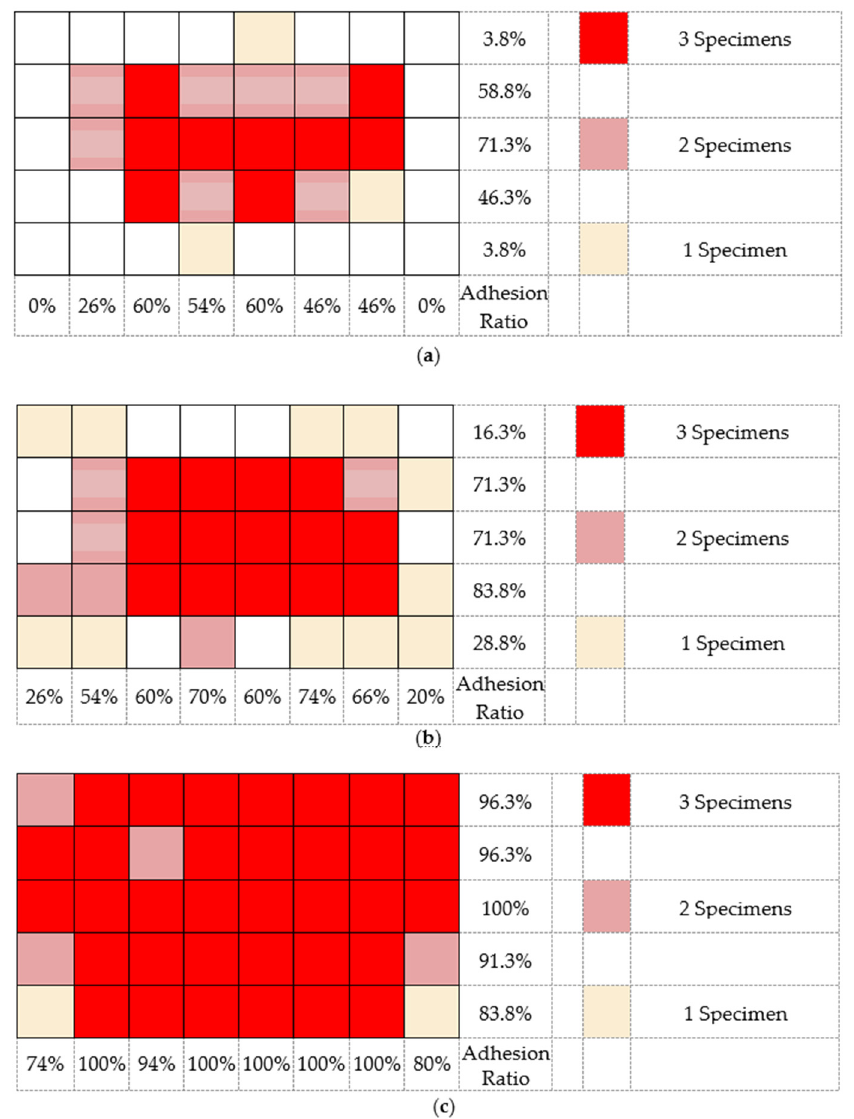
Figure 13. Adhesion ratio distribution map of specimens based on measurable adhesion strength pieces: ( a ) AR (adhesive-applied area ratios) 60 ± 2%; ( b ) AR 80 ± 2%; ( c ) AR